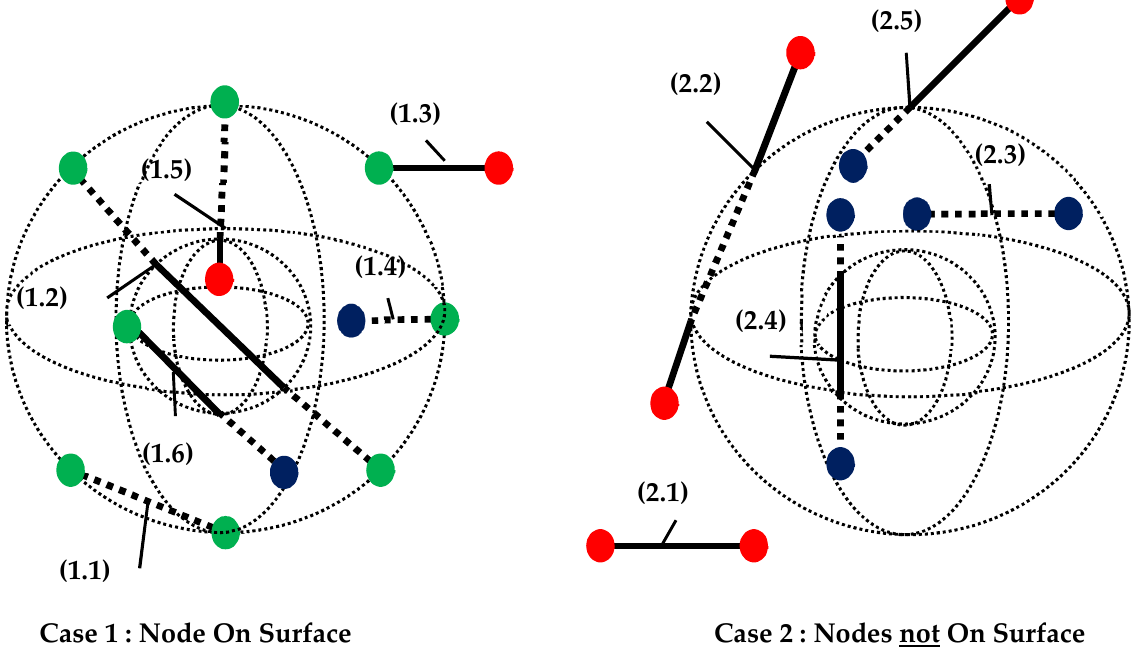
lines are line segments inside the hollow sphere and solid lines are located outside of the